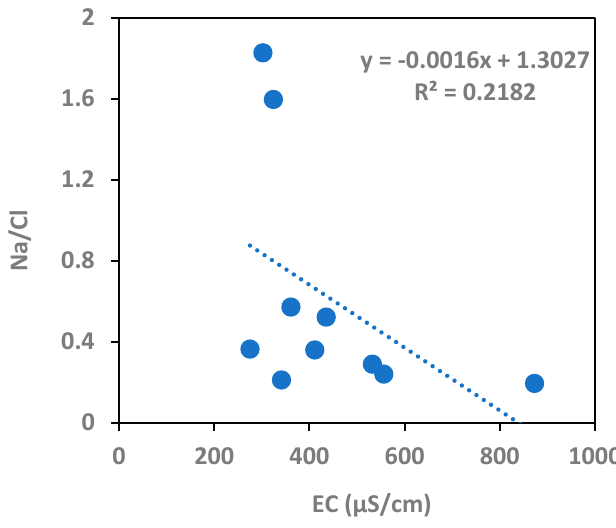
Figure 5. A plot of Na/Cl ratio versus EC.